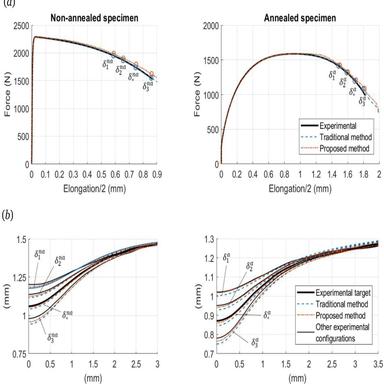
Results of the traditional approach and the proposed method in case of linear piecewise plasticity for both the samples. (a) Comparison of the force vs. stroke curve. (b) Comparison of the experimental and predicted specimen profile at different time instants.